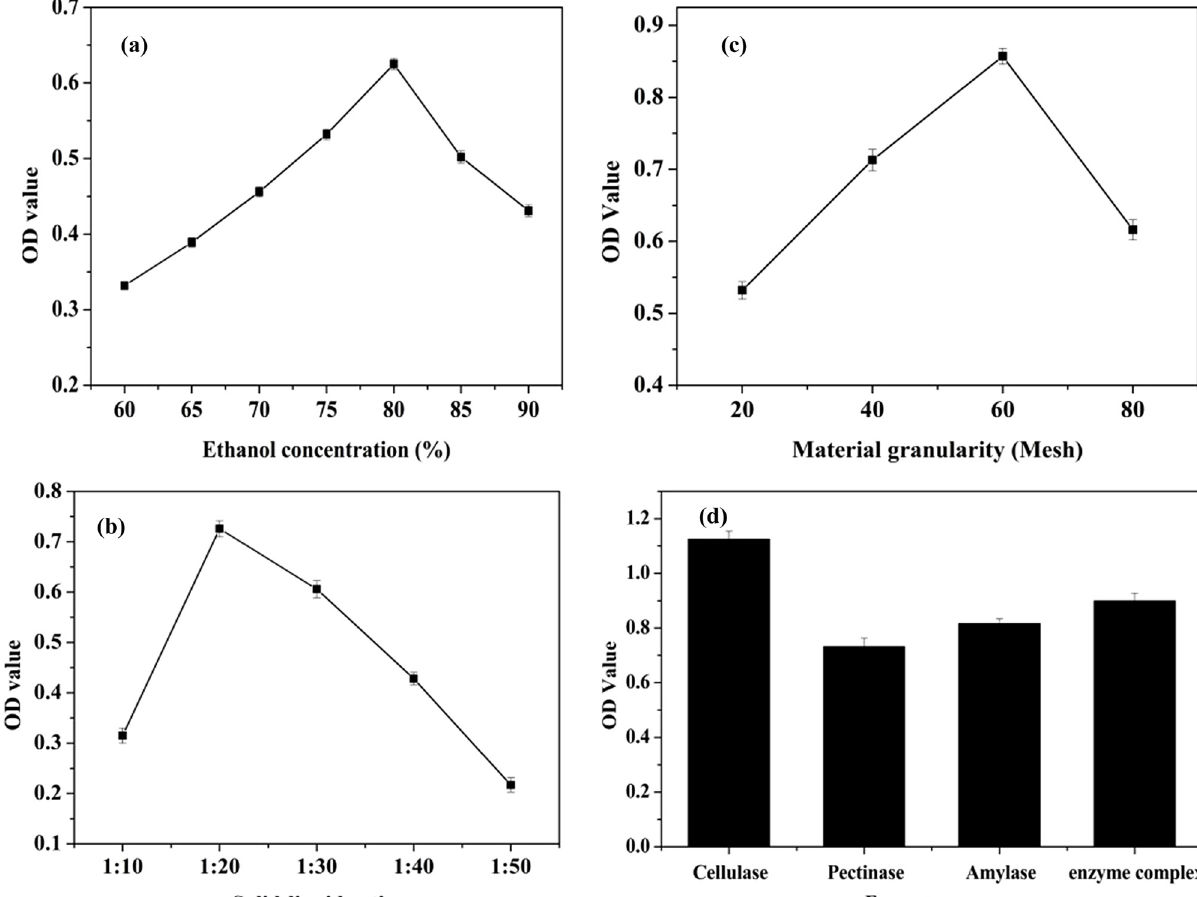
Figure 1: E ff ects of extraction factors on pigment yield. E ff ects of ethanol concentration ( a ) , solid - liquid ratio ( b ) , material granularity ( particle diameter of material ) ( c ) , and enzyme types ( d ) on the extraction e ffi ciency of red pigment from matured jujube fruits ( n = 3; error bar, a standard deviation of the sample, SD; OD value is the optical density value measured at 280 nm; 20 mesh, 1.6 mm; 40 mesh, 0.45 mm; 60 mesh, 0.28 mm; and 80 mesh, 0.18 mm )